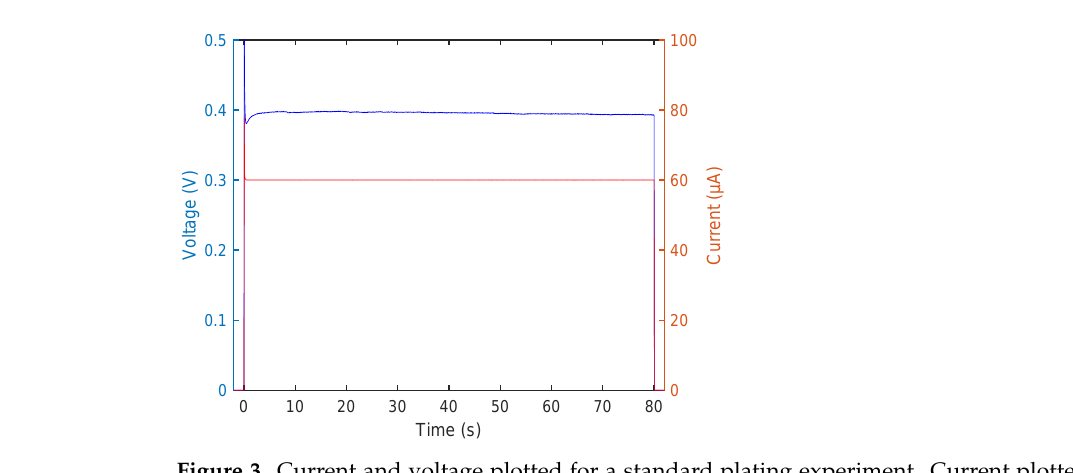
Figure 3. Current and voltage plotted for a standard plating experiment. Current plotted in red, voltage plotted in blue.